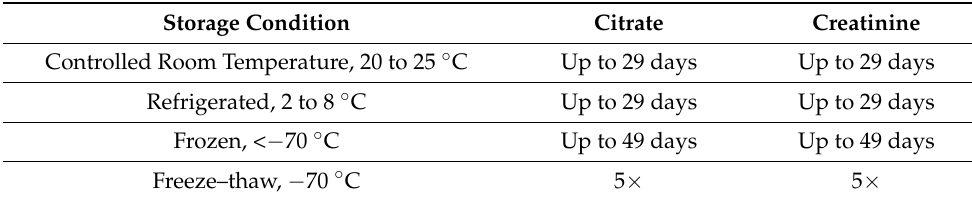
Table 2. Summary of citrate and creatinine stability in urine specimens. Storage Condition Citrate Creatinine Controlled Room Temperature, 20 to 25 ◦ C Up to 29 days Up to 29